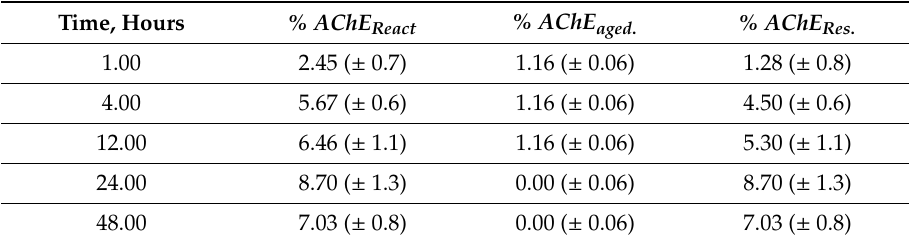
Table 1. Resurrection essays data obtained in the experiment with inhibited Hss AChE (Pub. No.: US 2016/0151342 A1).